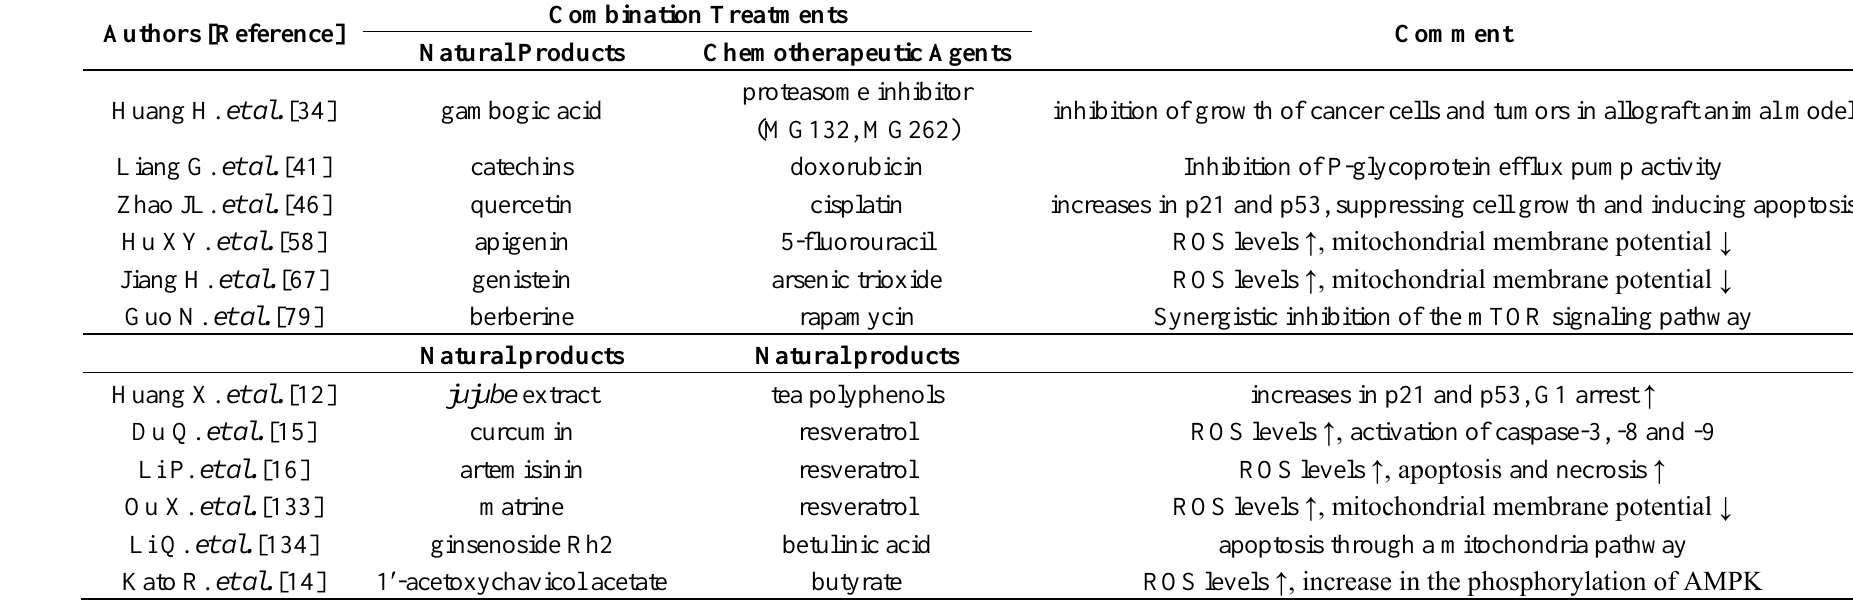
Table 1. Summary of synergistic anticancer activities of natural products in